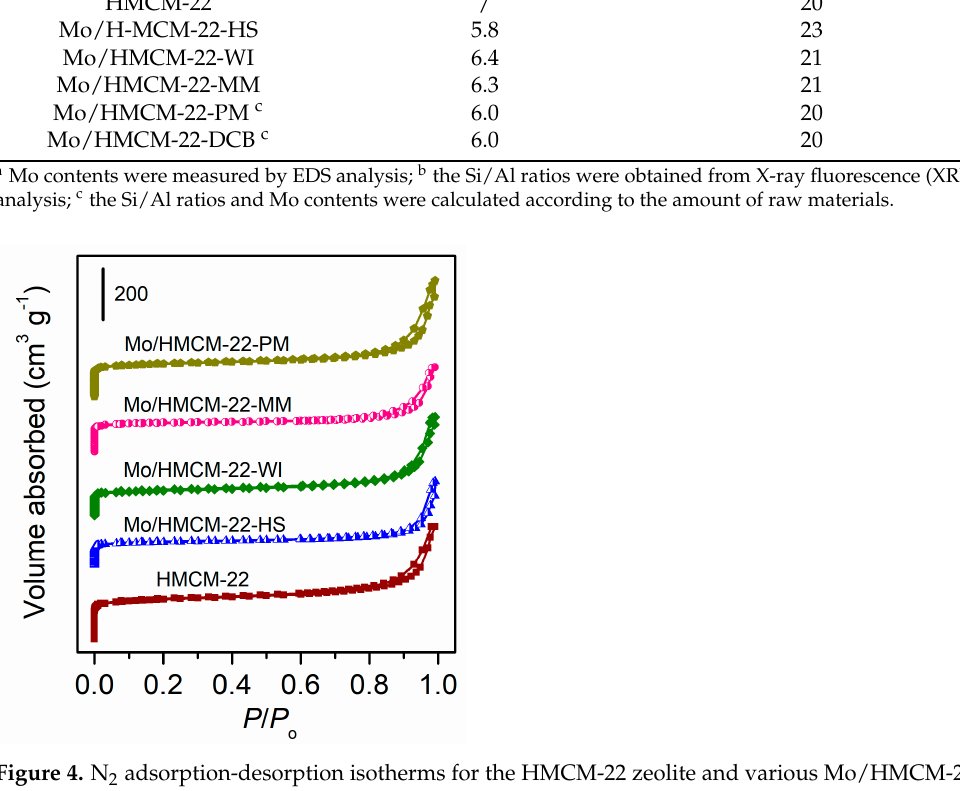
Table 1. Si/Al ratios and Mo contents for the HMCM-22 zeolite and Mo/HMCM-22 catalysts.